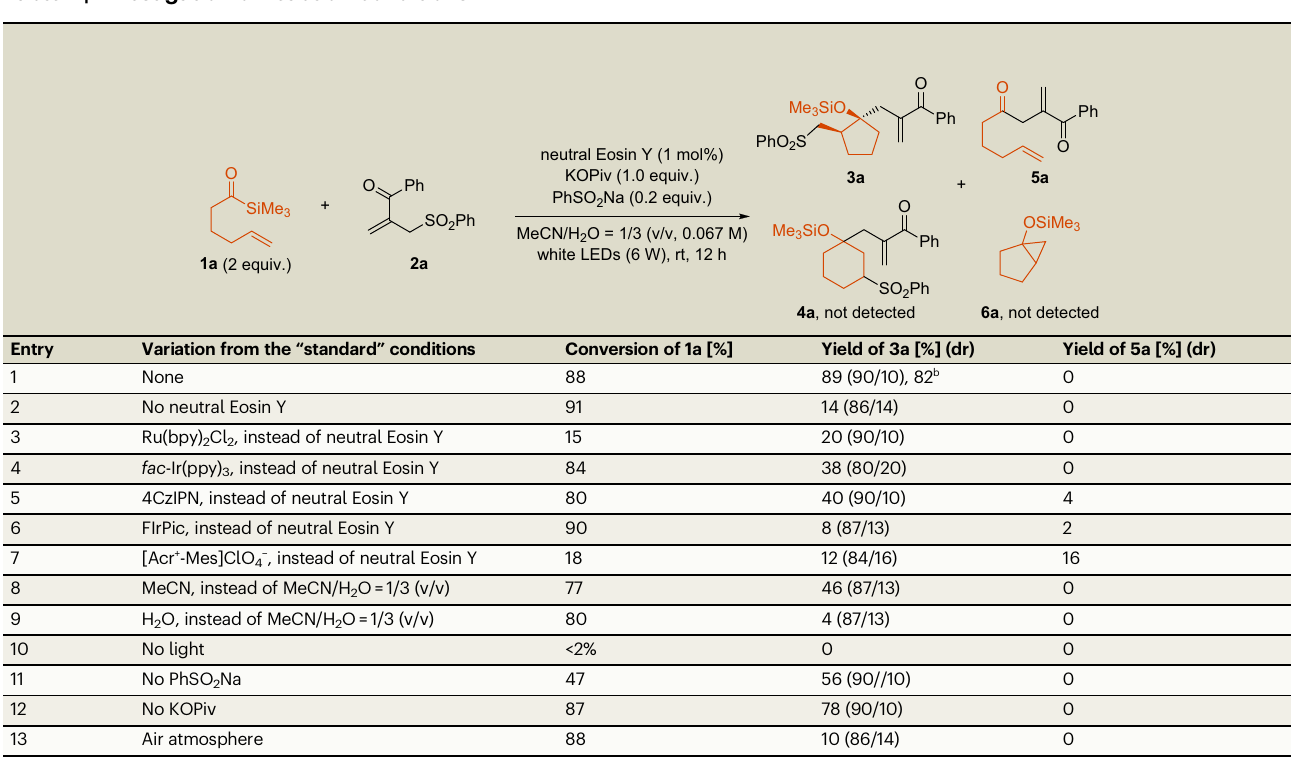
Table 1 | Investigation of reaction conditions